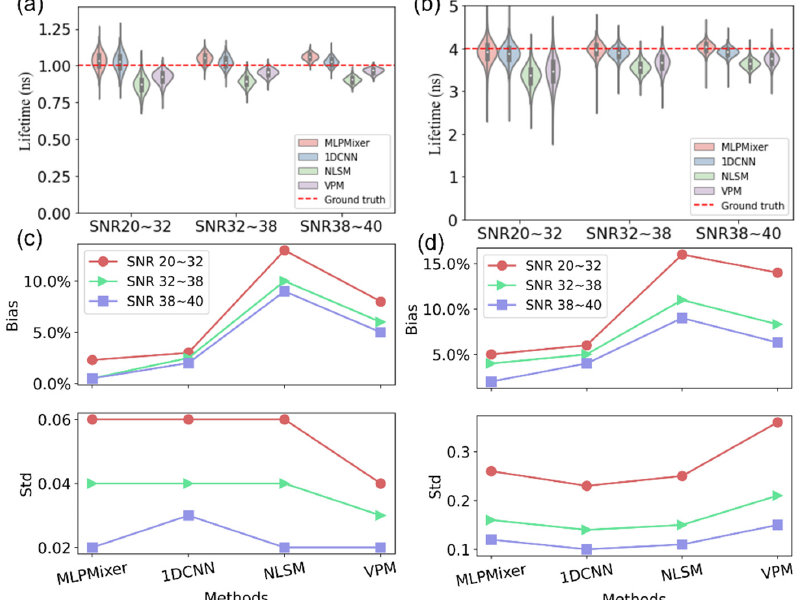
Figure 3. Boxplots of estimations under different signal-to-noise ratios (SNRs) with the four methods, in which the median and quartiles with whiskers reach up to 1.5 times the interquartile range. The violin plot outlines illustrate kernel probability density; for example, the width of the shaded area represents the proportion of the data. ( a ) Short lifetime (set at 1 ns) and ( b ) long lifetime (set at 4 ns) estimations from synthetic data; ( c , d ) corresponding bias and standard deviation plots for ( a ) short and ( b ) long lifetimes.